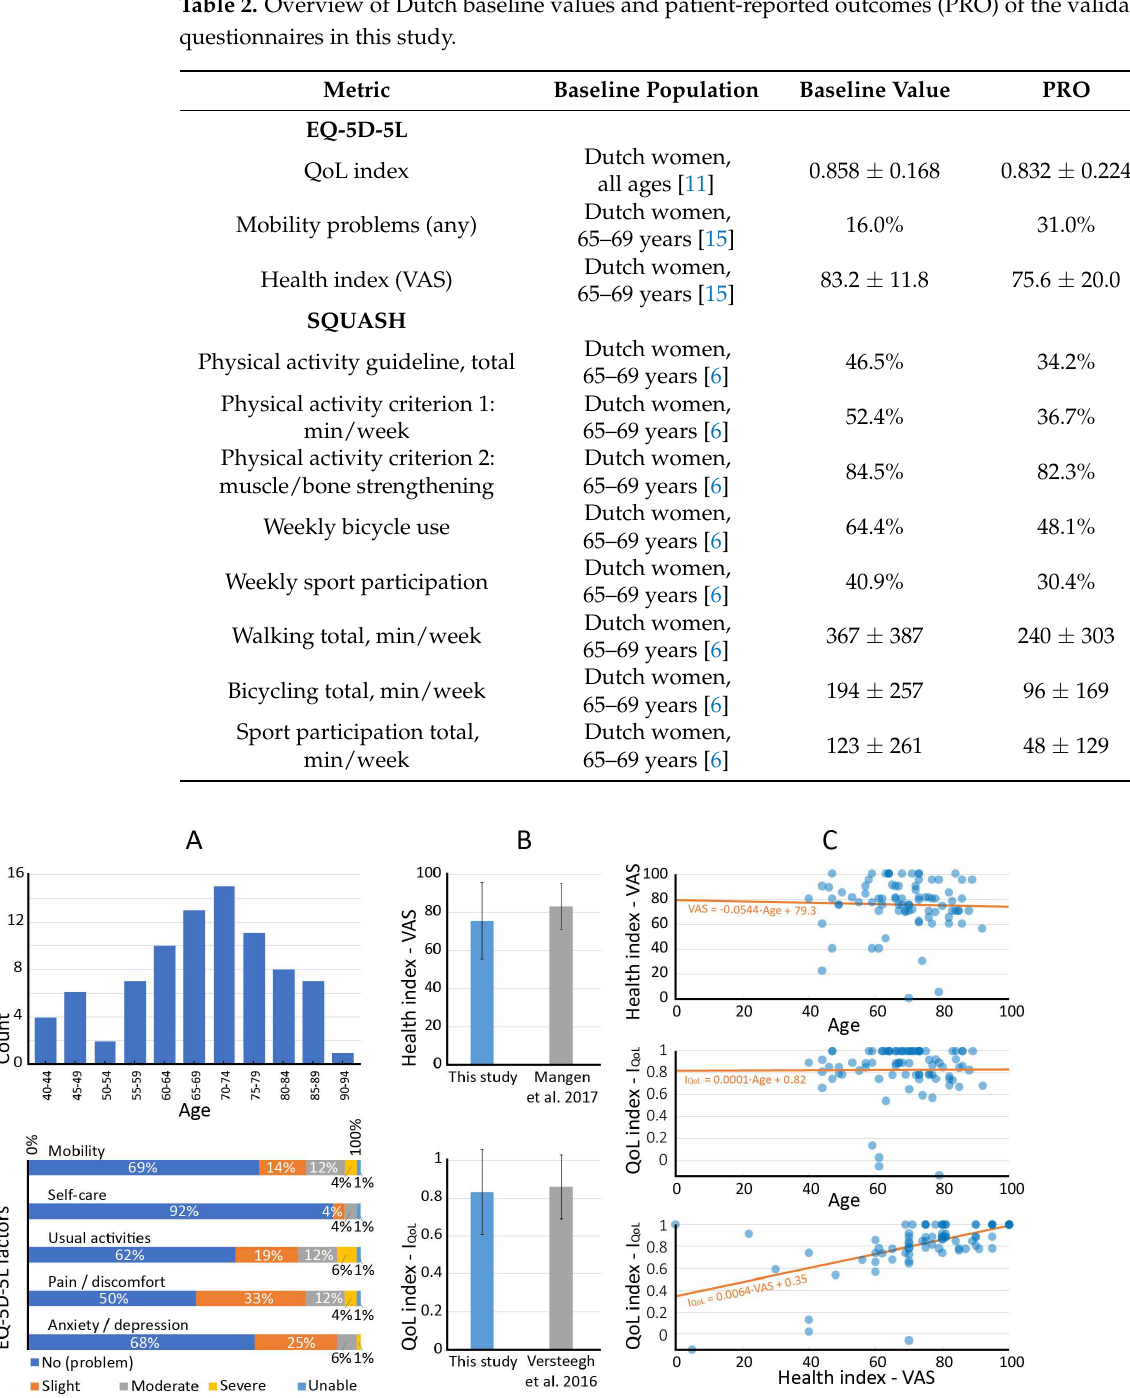
Figure 1. Population age histogram (n = 84) and EQ-5D-5L QoL factors presented as stacked bar graphs ( A ). Reported overall QoL and health are shown next to Dutch baseline values ( B ) [11,15]. Relations between age , the QoL index and the health index are shown with scatter plots and a linear fit line ( C